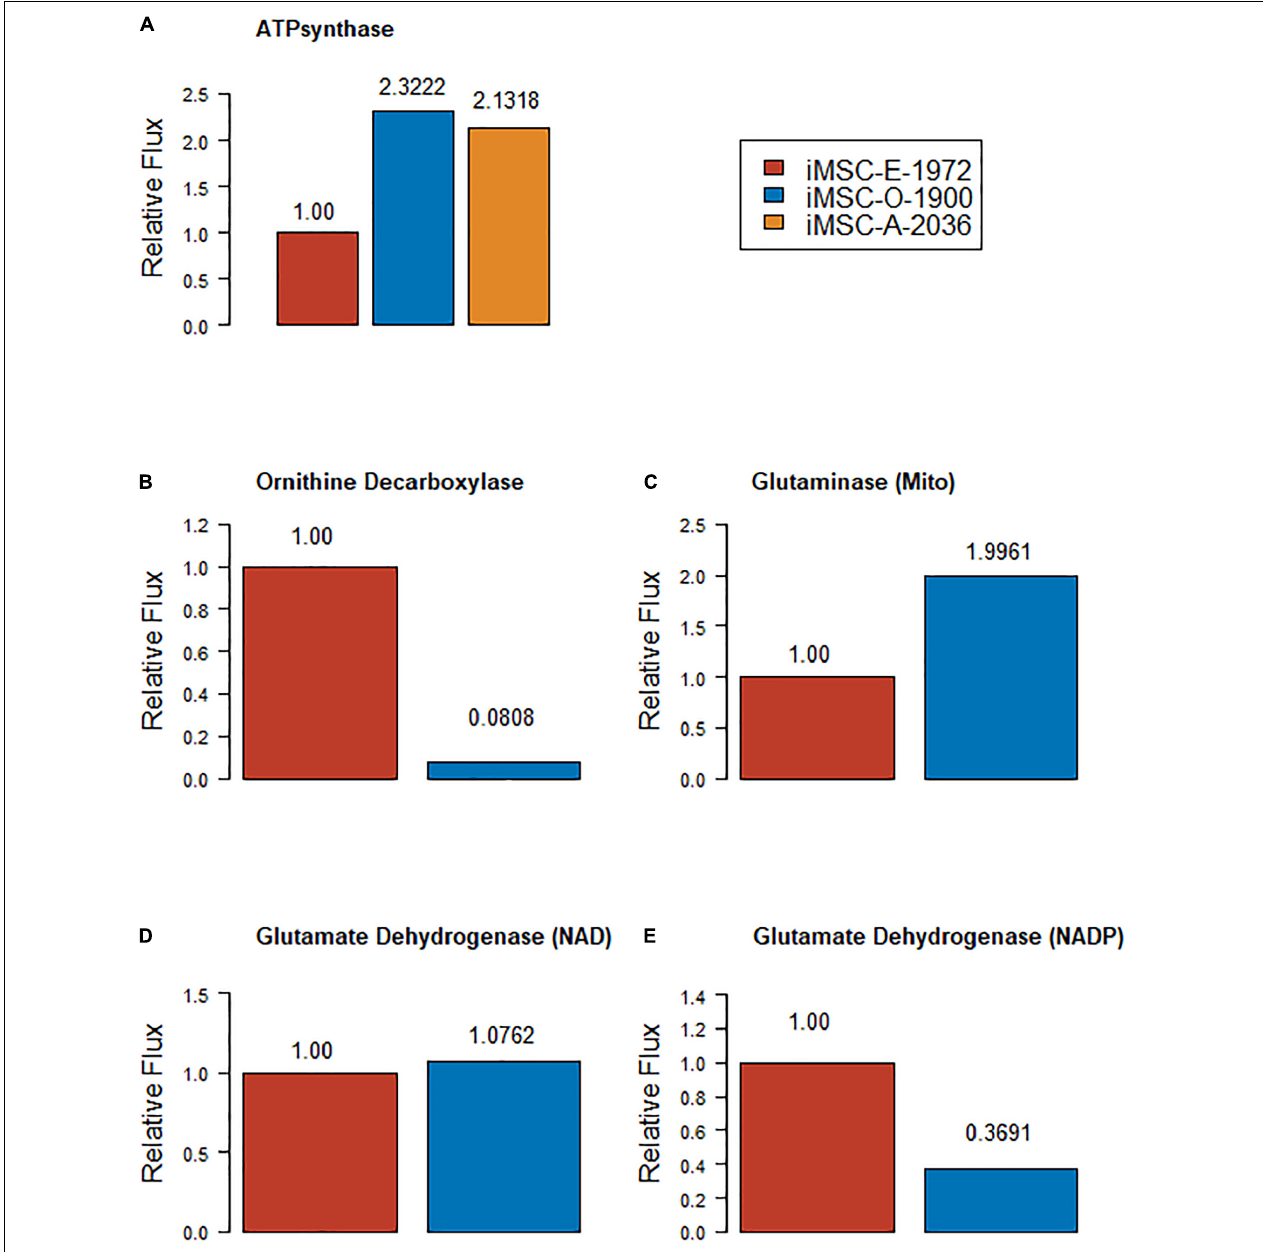
FIGURE 3 | Relative mean fluxes (compared to expansion model) from various reactions – (A) ATPsynthase (B) Ornithine decarboxylase (C) Mitochondrial glutaminase (D) NAD dependent glutamate dehydrogenase (E) NADP dependent glutamate